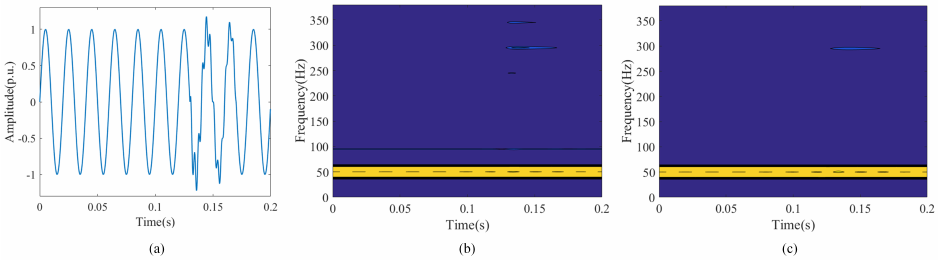
Figure 2. Comparison result on transients disturbance with different parameter β 1,2 . ( a ) Input signal, ( b ) β 1 = 150, β 2 = 40, ( c ) β 1 = 121, β 2 =